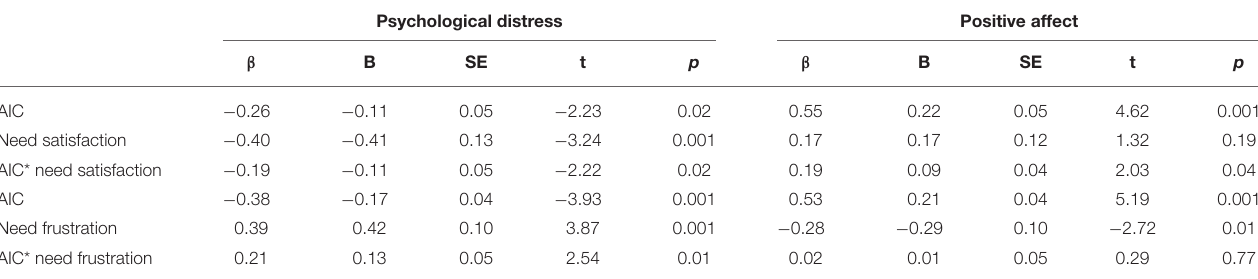
TABLE 4 | Regression analyses predicting Bedouin students’ psychological distress and positive affect. Psychological distress Positive